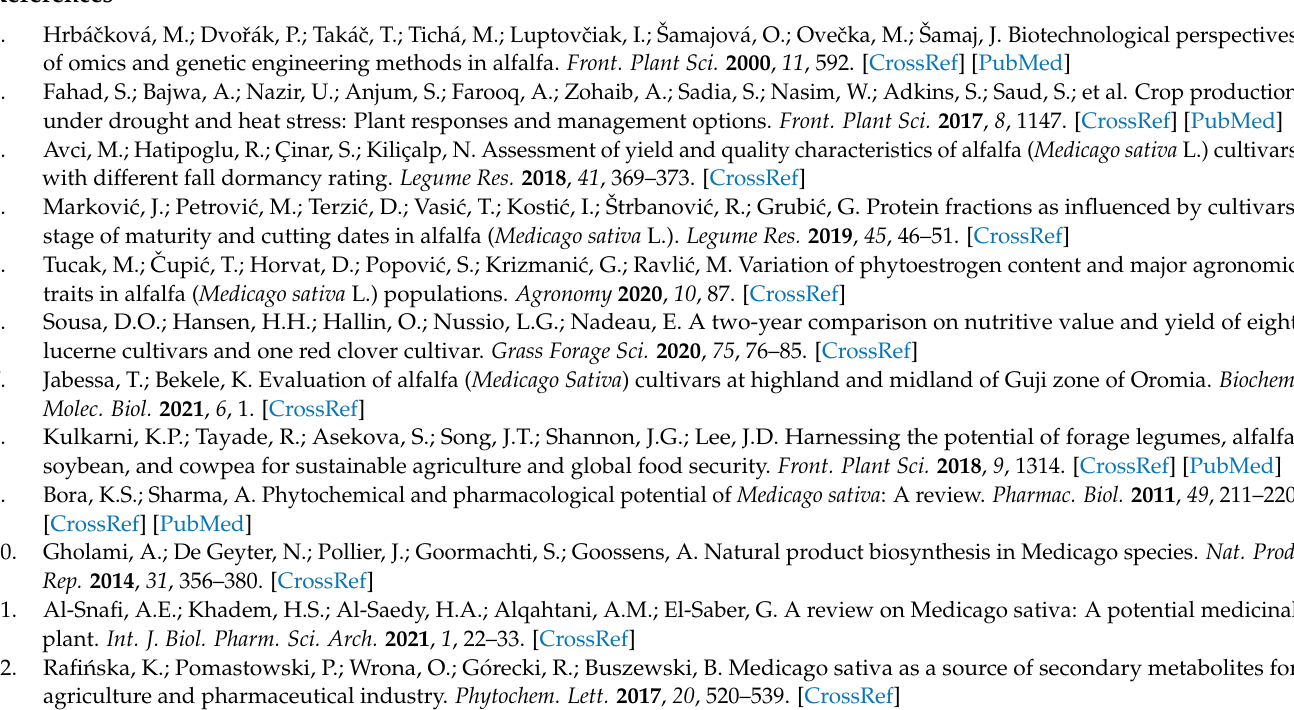
Table S5: Correlation matrix (Pearson ( p < 0.05)) of traits measured in alfalfa; Table S6: Eigenvalues; Table S7: Factor loadings and correlations between variables and factors; Table S8: Factor